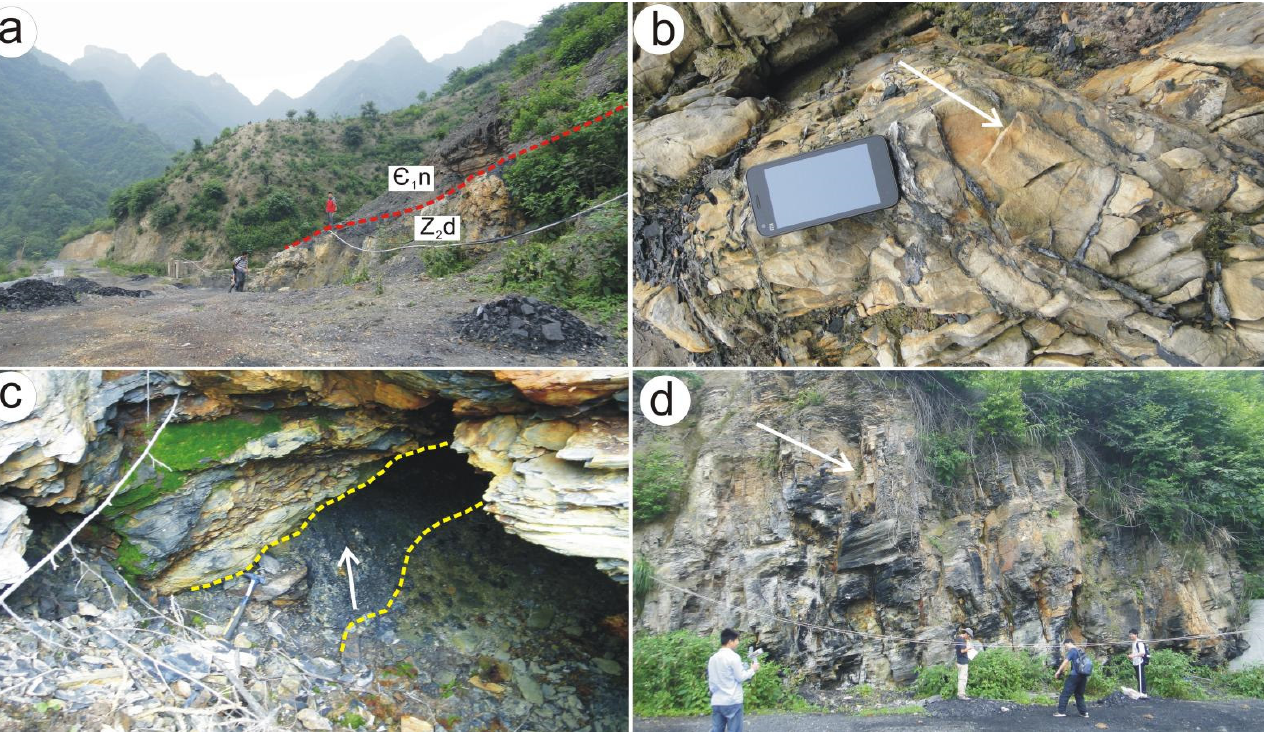
Figure 2. The lithological conditions of the uranium-polymetallic phosphorite layer and its contact with the upper and lower country rocks: ( a ) Contact of the Dengying–Niutitang Formations; ( b ) grey-white, thick, massive dolomite of the Dengying Formation (the arrowed points); ( c ) uranium- polymetallic phosphorite layer (the arrowed points); ( d ) black carbonaceous-argillaceous shales and slates (the arrowed points).